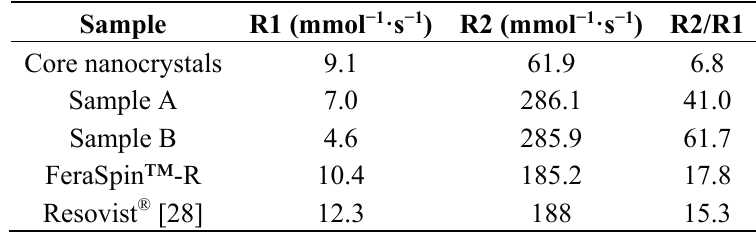
Table 2. NMR relaxivities (0.94 T, 39 °C in